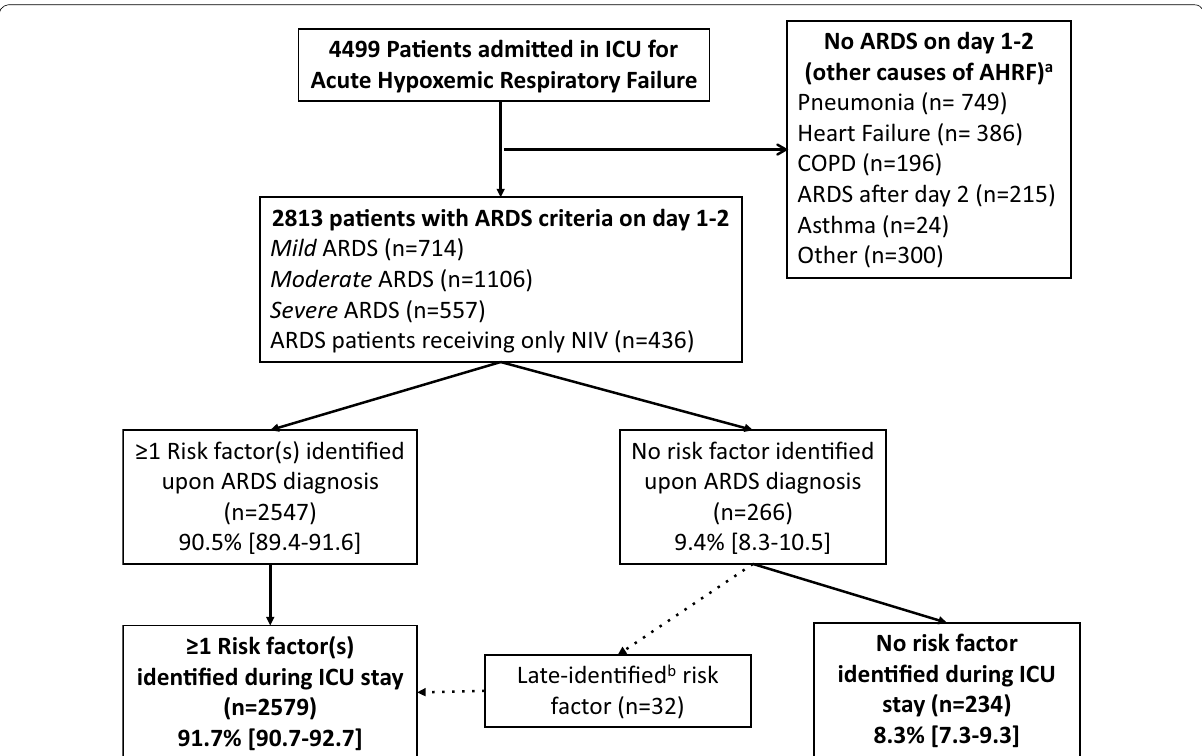
Fig. 1 Flow of patients with acute hypoxic respiratory failure (AHRF) enrolled in the study. ICU, intensive care unit; ARDS, acute respiratory distress syndrome; COPD, chronic obstructive respiratory disease; a Patients could have more than one cause of acute hypoxic respiratory failure; b Factors identified during the course of ICU